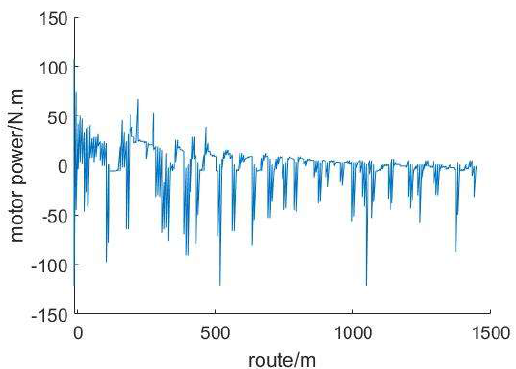
Figure 19. Logic gate control motor power.